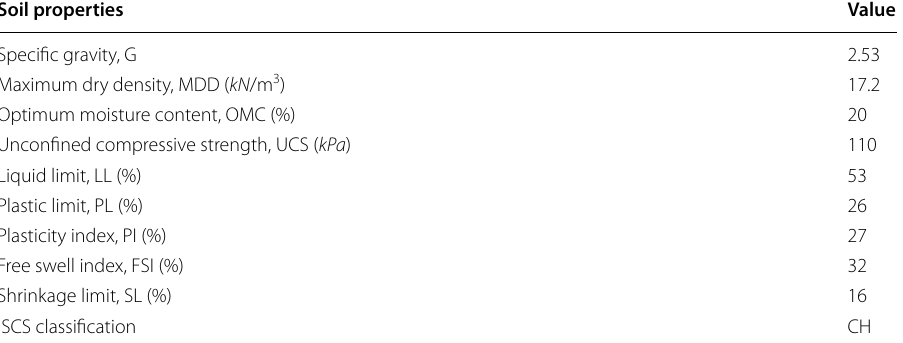
Table 1 Geotechnical properties of the clayey soil Soil